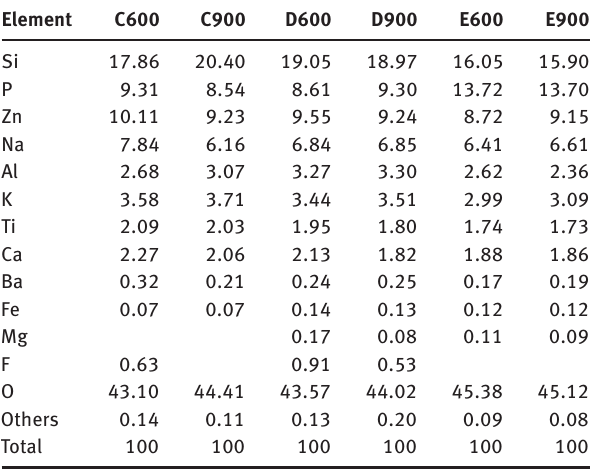
Table 3: Major components of C600, C900, D600, D900, E600 and D900 in terms of elements in